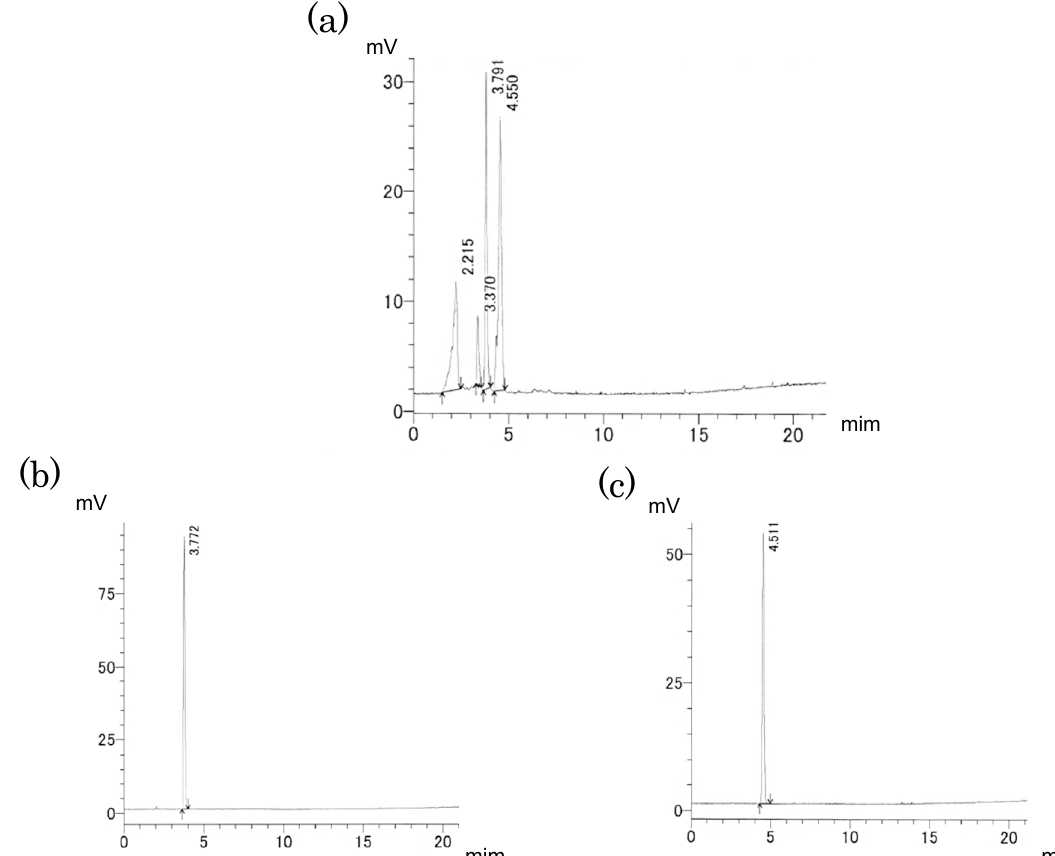
Figure 8. HPLC analysis of sugars. ( a ) > 3 kDa fraction of the corn silk water extract. ( b ) Xylose. ( c )